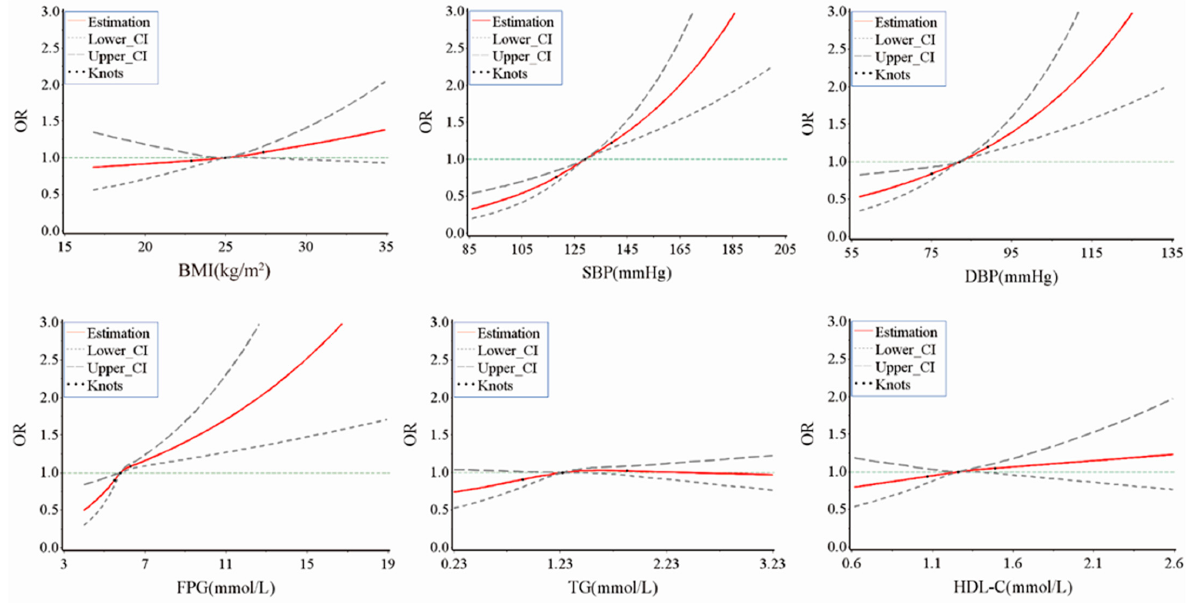
Figure 2. Association of the continuous metrics of BMI and metabolic indicators and the odds of carotid plaque from RCS models. Point estimates of OR or difference, upper and lower 95% Cis, and knots are indicated by red solid lines, grey long dashed lines, grey short dashed lines, and green dots respectively. Adjusted for age, sex, educational level, smoking status, drinking status, physical activity, DASH score, diabetes status, and hs-CRP. BMI, body mass index; SBP, systolic blood pressure; DBP, diastolic blood pressure; FBG, fasting blood glucose, TG, triglycerides; HDL-C, high-density lipoprotein cholesterol.